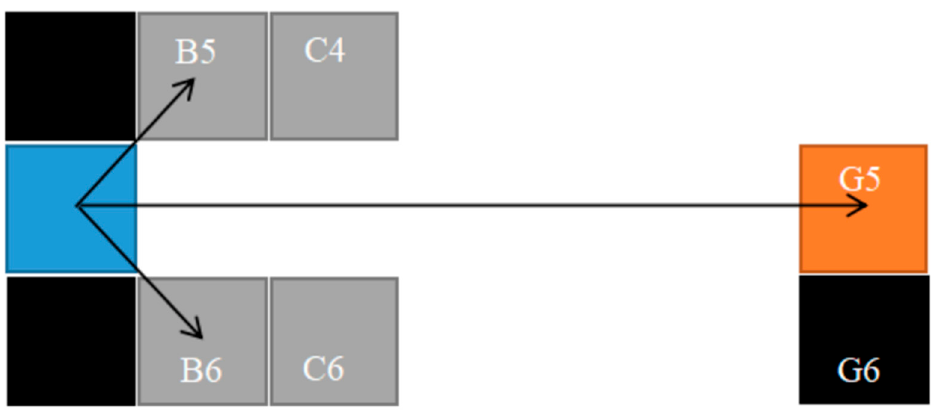
Figure 3. The shortest path selection example of JPS algorithm.